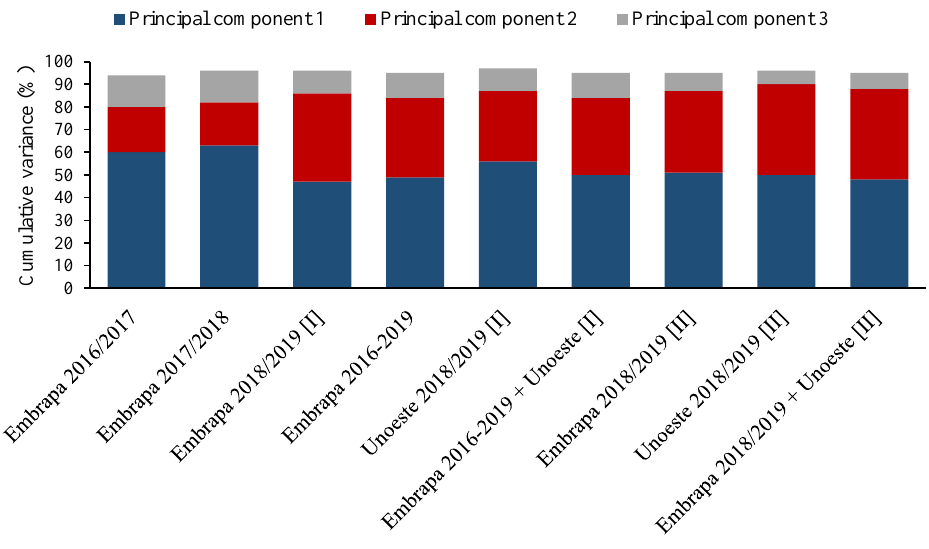
Figure 8. Principal component analysis of each spectral dataset.